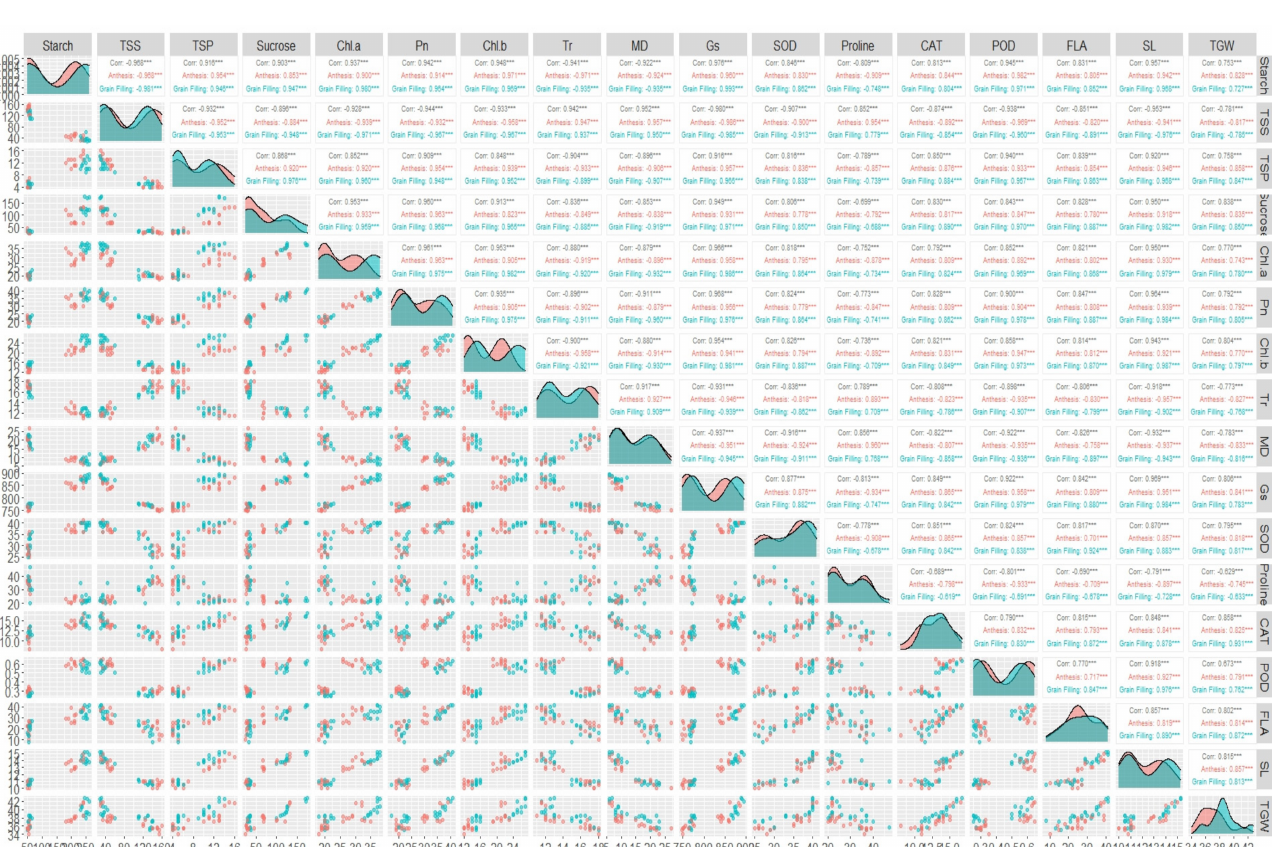
Figure 7. Significance of the correlation among osmolytes, physiological parameters, antioxidants and agronomic traits at anthesis and grain-filling stages of wheat genotypes. *** = Significant at p ≤ 0.001; ** = Significant at p ≤ 0.01. TSS, total soluble sugar; TSP, total soluble proteins; SC, stomatal conductance; TR, transpiration rate; MD, membrane damage; PR, photosynthesis rate; SOD, superoxide dismutase; CAT, catalase; POD, peroxidase; FLA, flag leaf area; SL, spike length; TGW, thousand grain